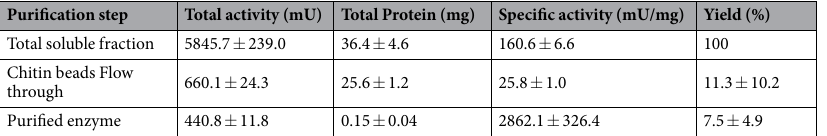
Table 1. Purification of Chia from chicken glandular stomach. The purified protein was prepared from the 1 g of the glandular stomach as described in